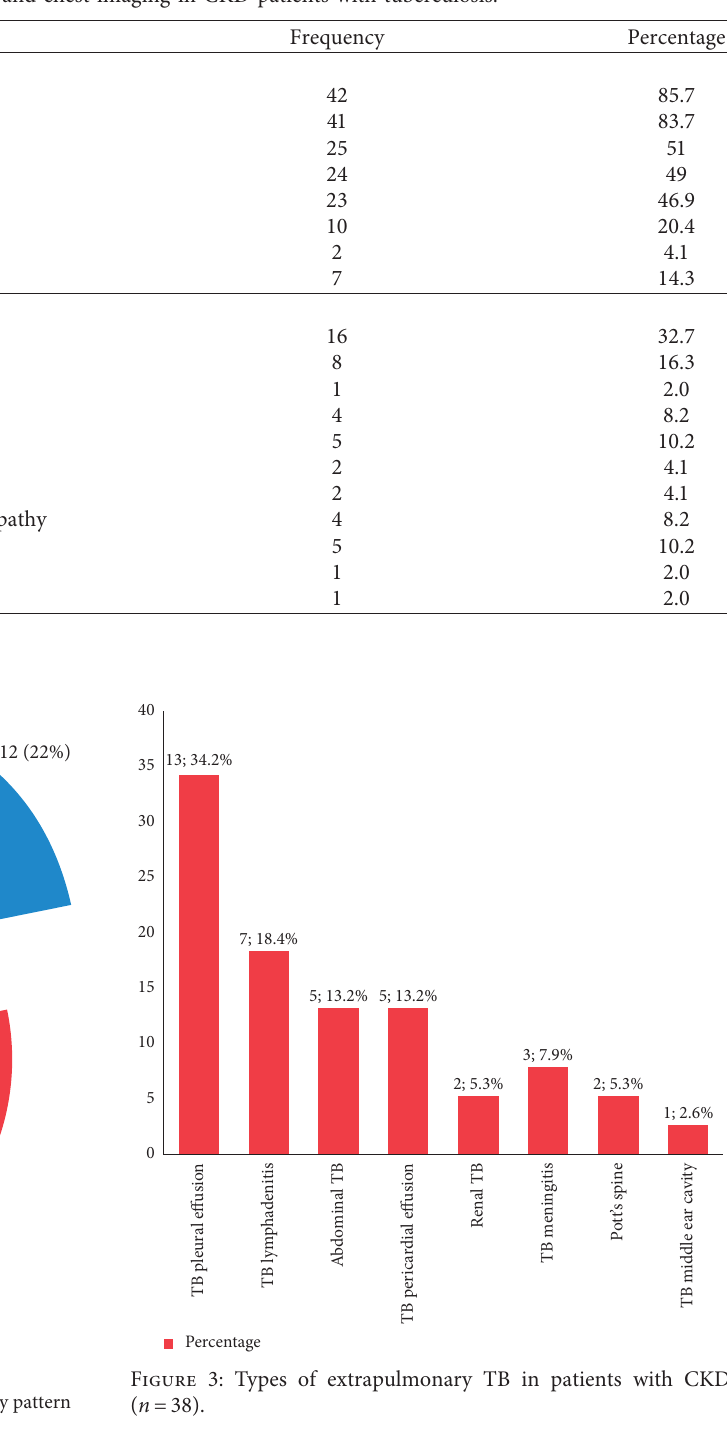
Figure 2: Types of tuberculosis in patients with CKD ( n � 55).